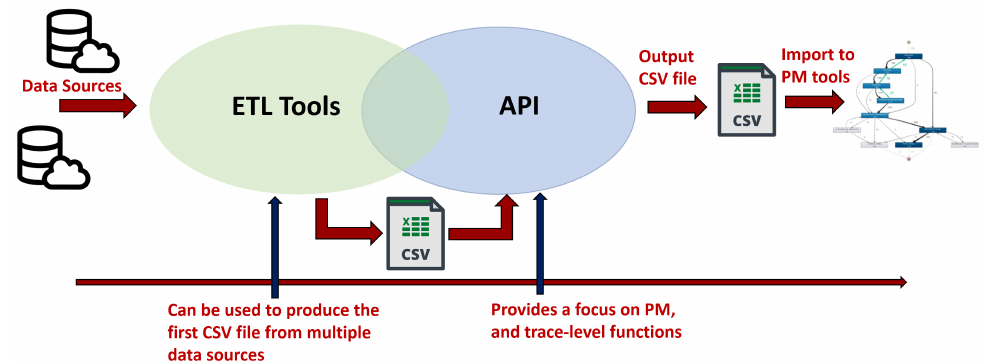
Figure 1. Relationship between ETL and a desirable API for